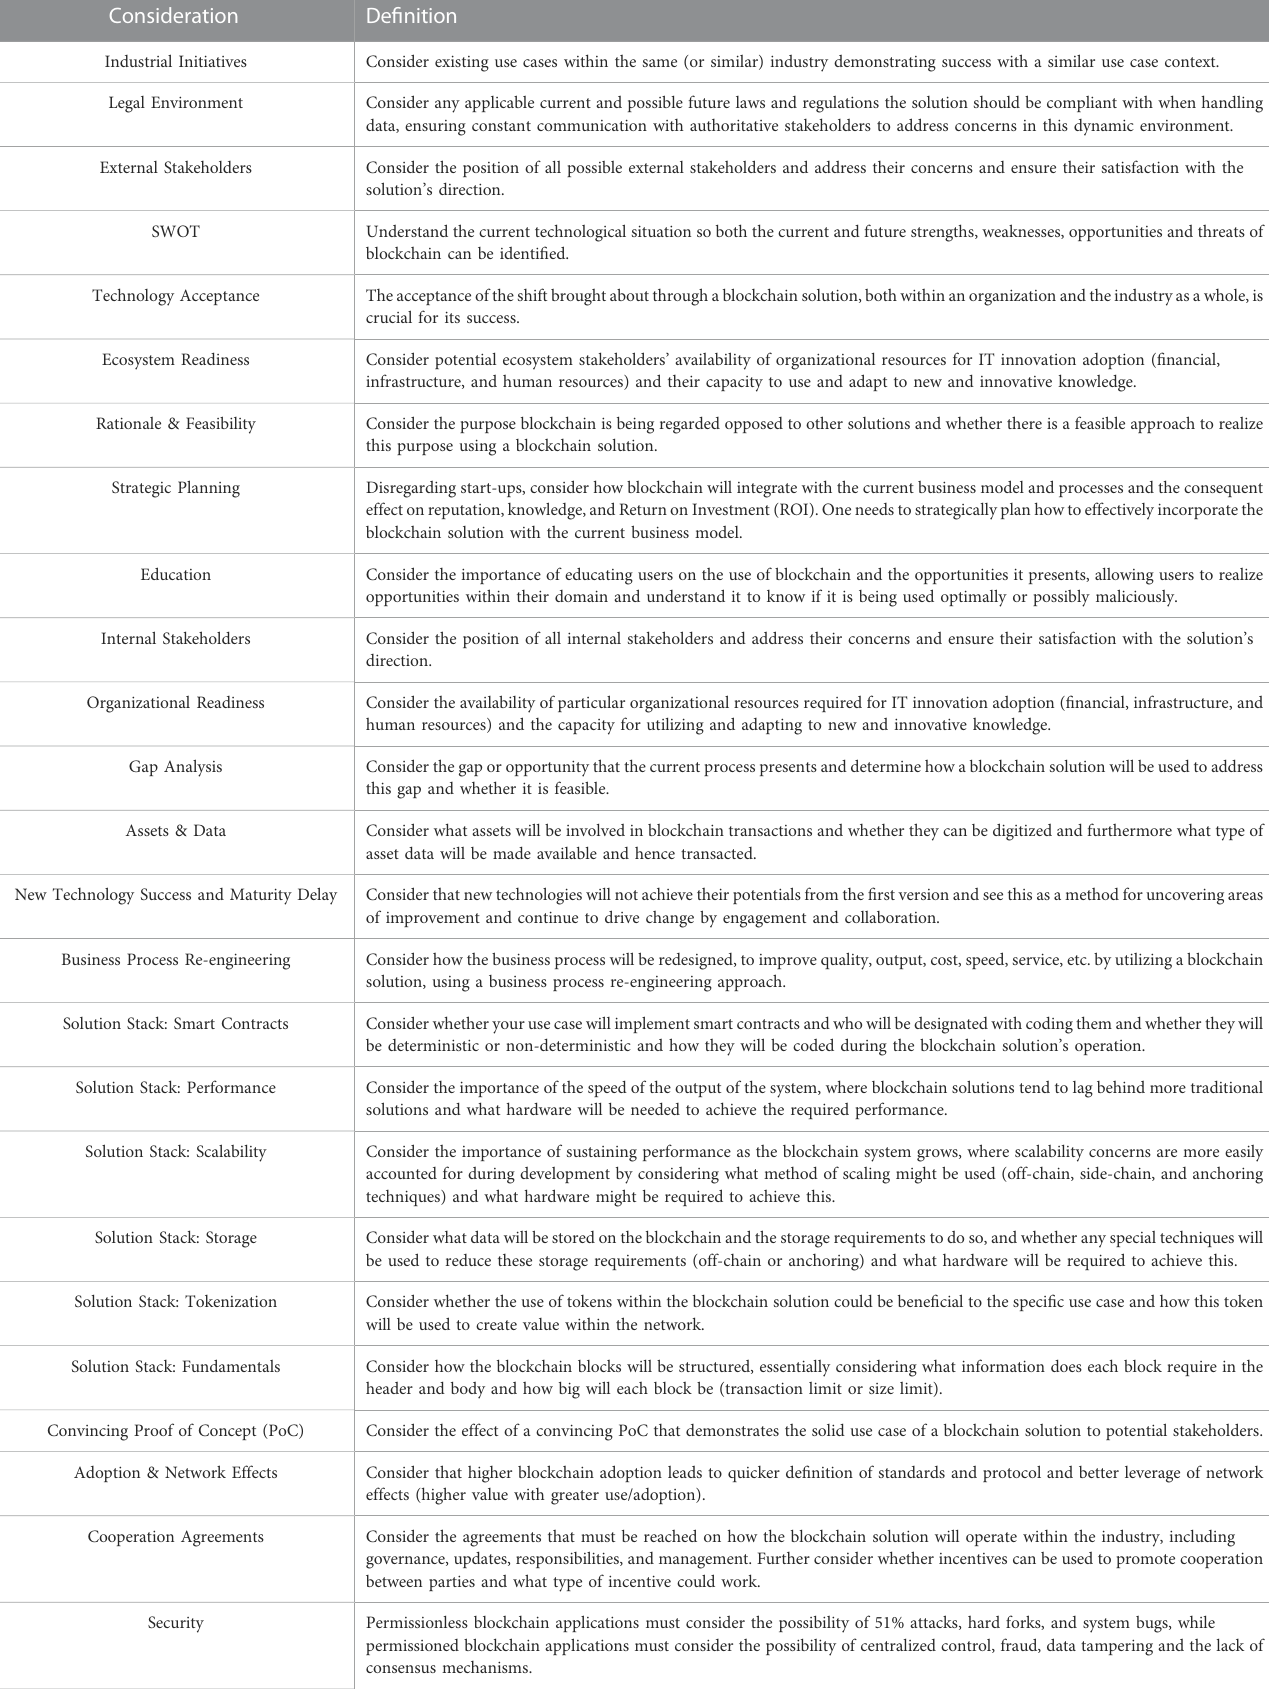
TABLE 8 Blockchain Adoption Considerations De fi